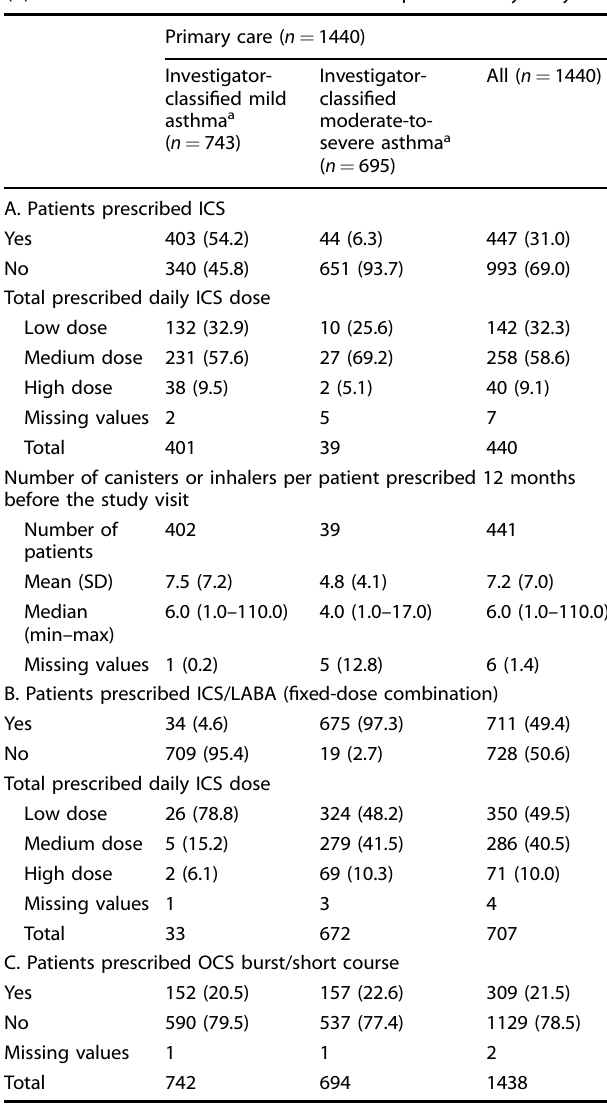
Table 4. Patients in the SABINA III PCP cohort who received prescriptions for (A) ICS, (B) ICS/LABA ( fi xed-dose combination), and (C) OCS burst/short course in the 12 months prior to study